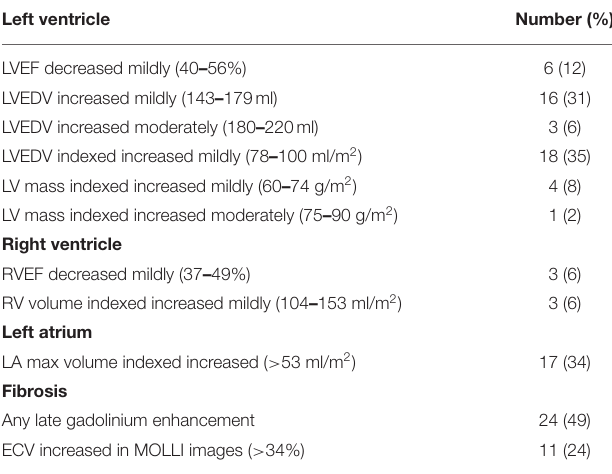
TABLE 5 | Cardiac MRI abnormalities in 52 women with pathogenic DMD